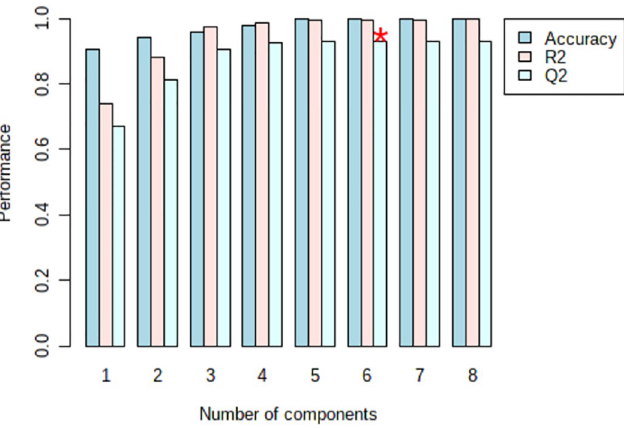
Fig 8. PLS-DA classification. The red star indicates the best classifier. (Accuracy = 1, R2 = 0.995, Q2 = 0.931.